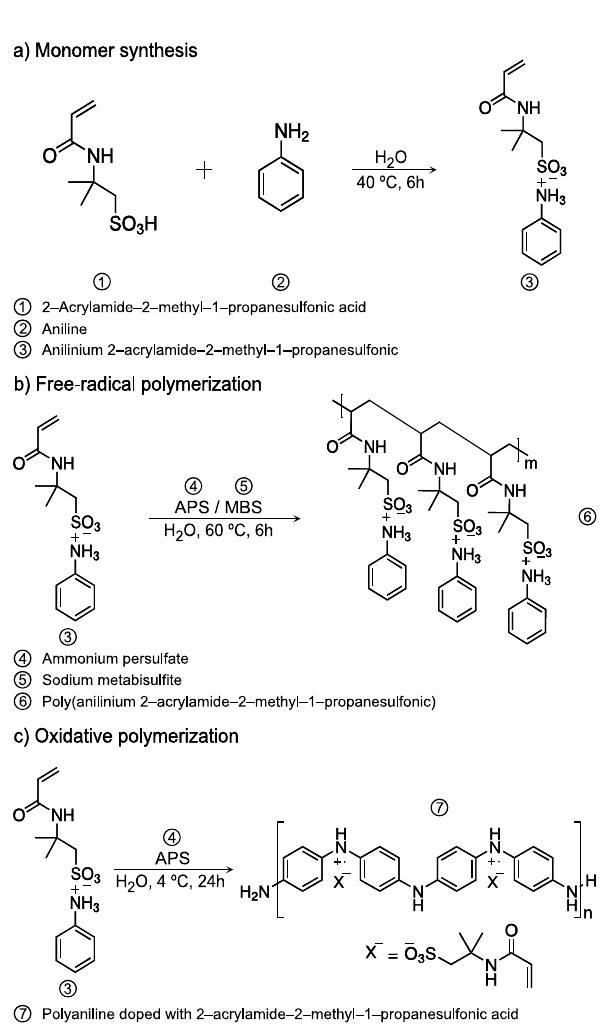
Figure 1. The synthesis scheme of ( a ) Ani-AMPS; ( b ) free-radical polymerization of Ani-AMPS monomer; and ( c ) oxidative polymerization of Ani-AMPS monomer.